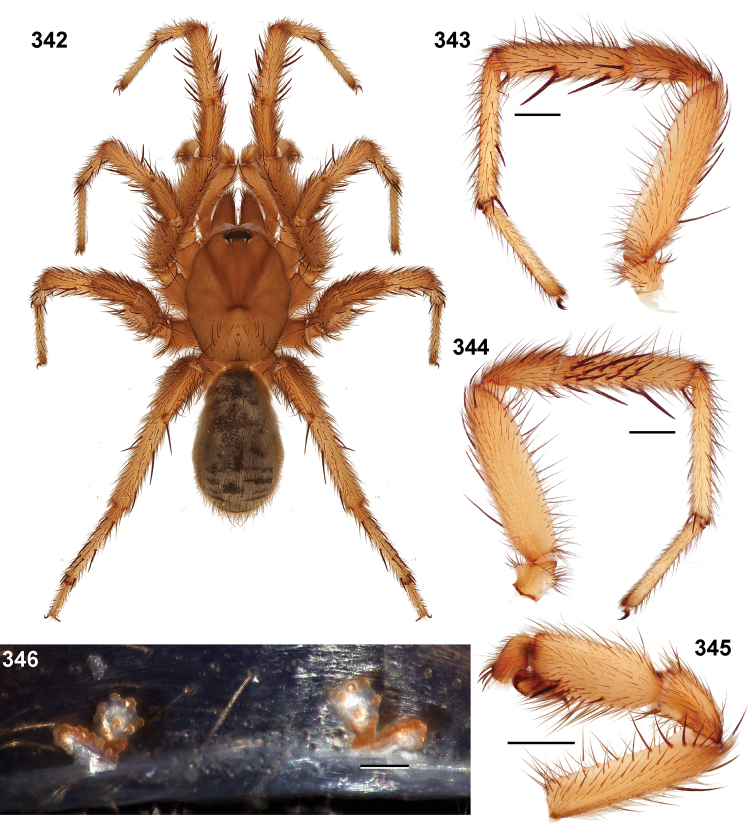
Aptostichus dorothealangeae sp. n. from Kern County. 342–345 male holotype (AP426); scale bars = 1.0mm 342 habitus [806412] 343 retrolateral aspect, leg I [806416] 344 prolateral aspect, leg I [806418] 345 retrolateral aspect, pedipalp [806420] 346 cleared spermathecae (AP732) [806421]; scale bar = 0.1mm.